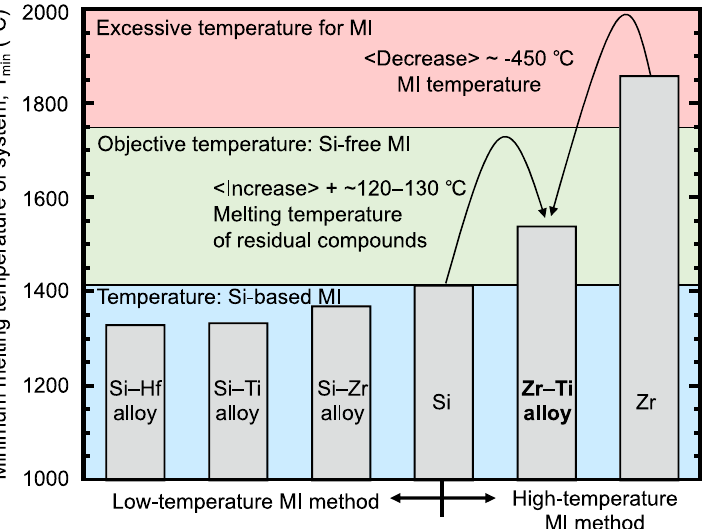
Figure 1. Temperature required for melt infiltration (MI) of various metals and